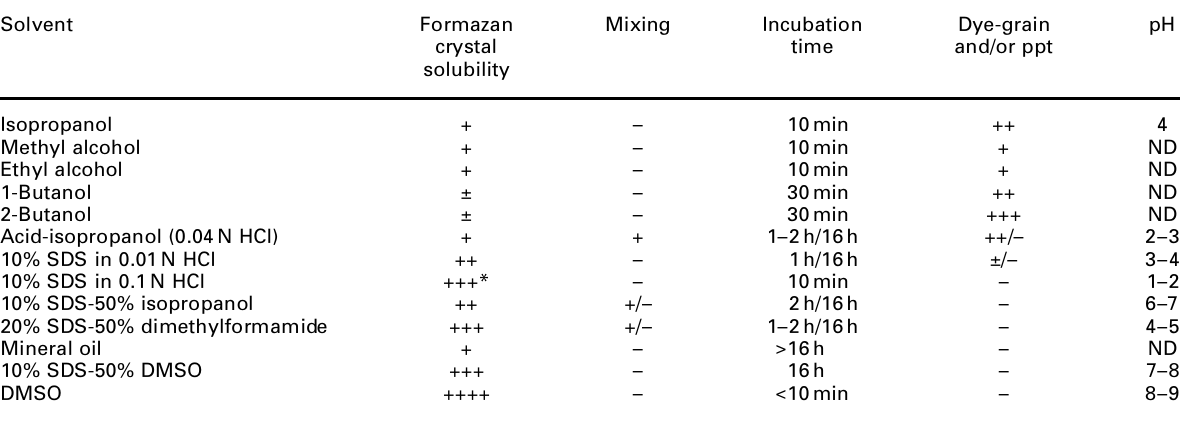
Table 2. Comparison of dissolving capacity of various solvents to Formazan crystals